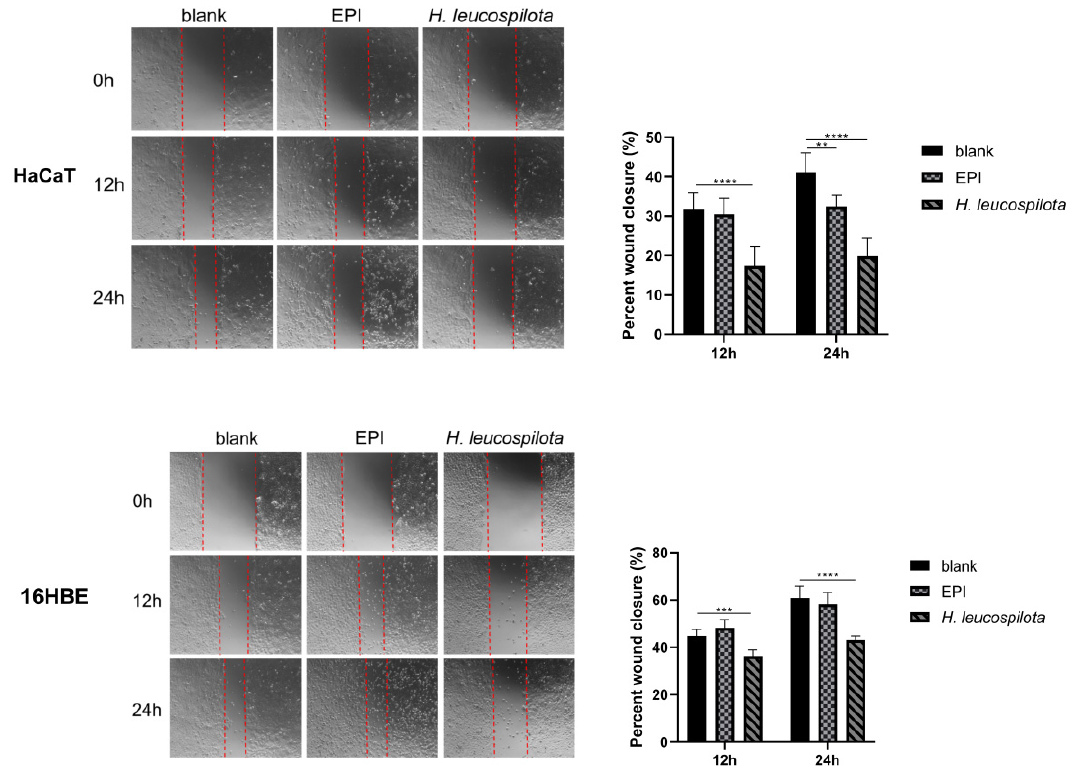
Figure 5. Effect of H. leucospilota protein treatment on cellular migration. Wounds were introduced in HepG2, A549, Panc02, NIH-3T3, HaCaT and 16HBE confluent mono-layers cultured in the presence or absence (control) with the IC 50 concentrations of H. leucospilota protein for 0, 12, and 24 h, and EPI (10 µ M) as positive group. Migration rate of HepG2, A549, Panc02, NIH-3T3, HaCaT, 16HBE in Figure. Experiments were repeated at least three times. Data are expressed as mean ± SD. * p < 0.05, ** p < 0.01, *** p < 0.001, **** p < 0.0001.